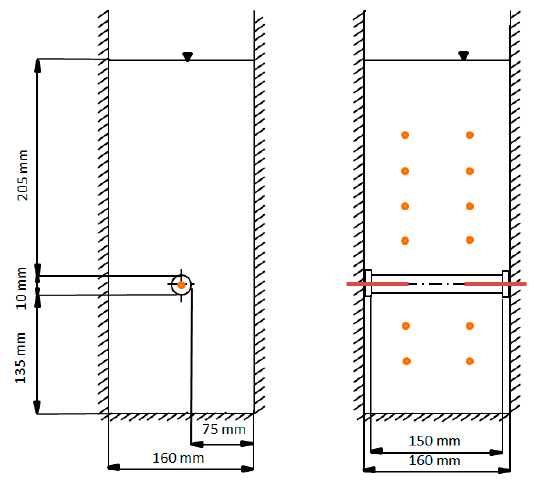
Figure 2. Scheme of the experimental container.